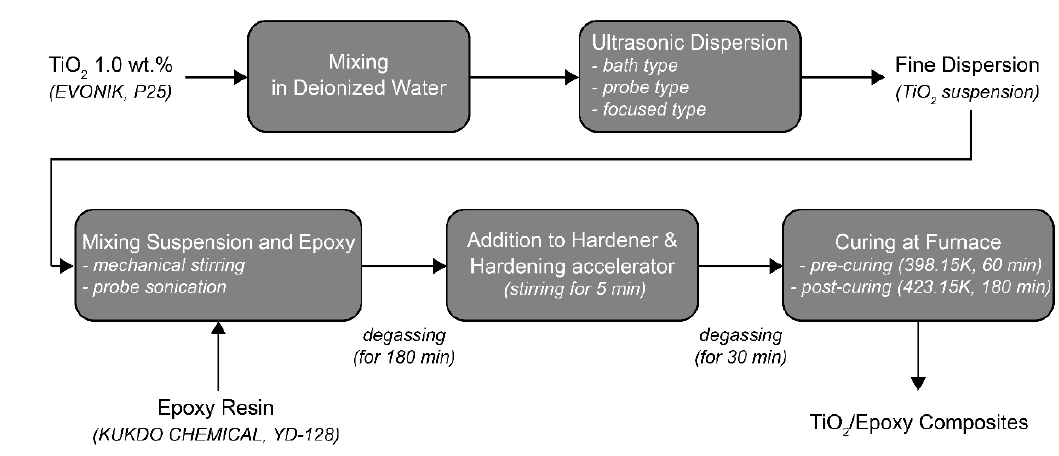
Figure 4. Flowchart of TiO 2 –epoxy nanocomposite preparation.